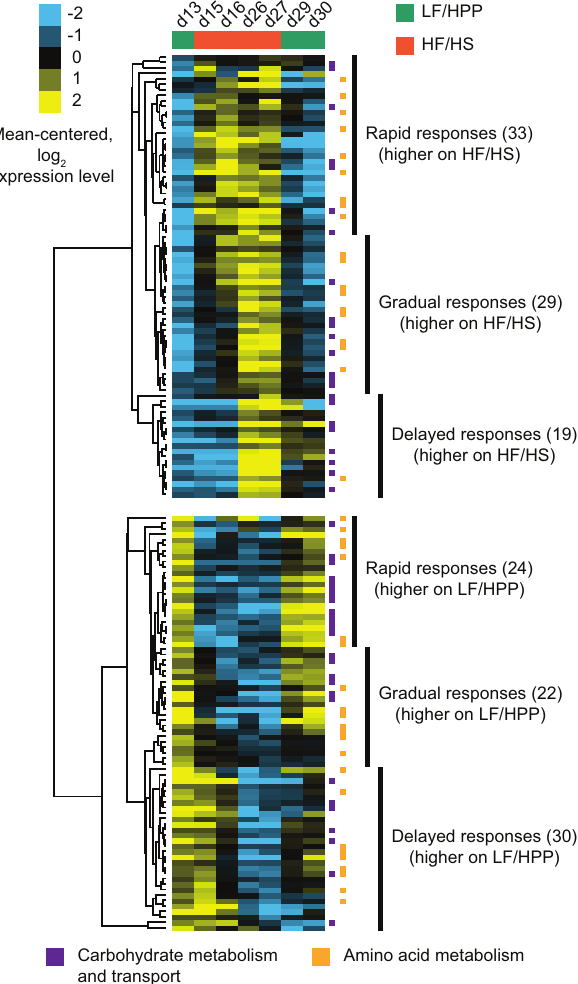
Figure 3. Top-down analysis of fecal microbiome RNA expres- sion in mice receiving oscillating diets. The fecal metatranscrip- tomes of four animals in the LF/HPP R HF/HS R LF/HPP treatment group of E 2 were analyzed using microbial RNA-Seq at seven time-points to evaluate the temporal progression of changes in expressed microbial community functions triggered by a change in diet. After aligning reads to genes in the defined artificial human gut microbiome, raw counts were collapsed by the functional annotation (EC number) of the gene from which the corresponding reads originated. Total counts for each EC number in each sample were normalized, and any EC numbers demonstrating a statistically significant difference in their representa- tion in the metatranscriptome between the final days of the first two diet phases were identified using a model based on the negative binomial distribution [57]. Normalized expression values for 157 significant EC numbers (out of 1,021 total tested) were log-transformed, mean-centered, and subjected to hierarchical clustering, followed by heatmap visualization. ‘‘Rapid’’ responses are those where expression increased/decreased dramatically within 1–2 d of a diet switch. ‘‘Gradual’’ responses are those where expression changed notably, but slowly, between the two diet transition points. ‘‘Delayed’’ responses are those where significant expression changes did not occur until the end of a diet phase. EC numbers specifying enzymatic reactions relevant to carbohydrate metabolism and/or transport are denoted by purple markers, while those with relevance to amino acid metabolism are indicated using orange markers. A full breakdown of all significant responses over time and the outputs of the statistical tests performed are provided in Table S7.